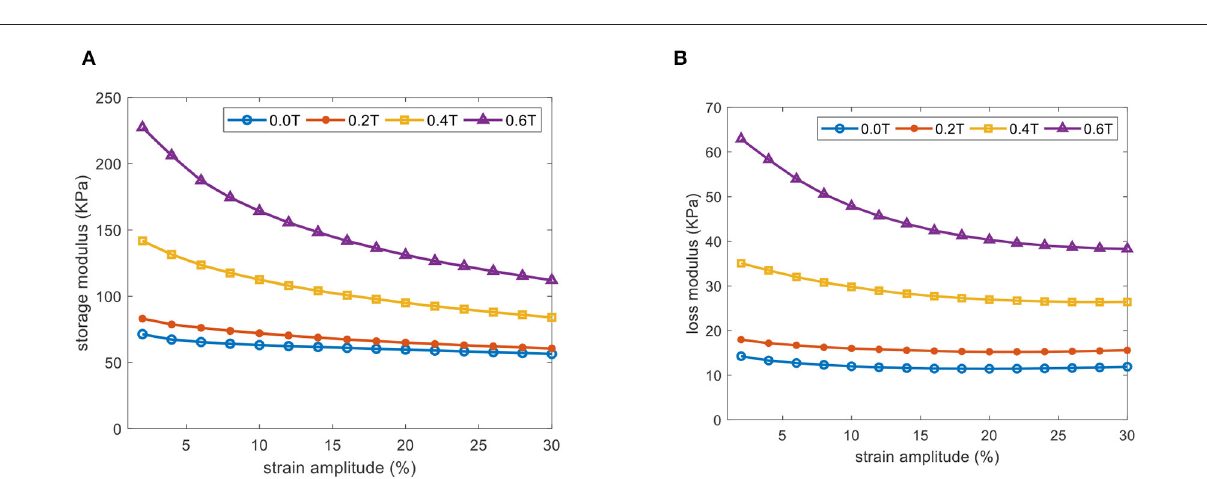
d 4 = 13.27 are identified using the least square method. The results obtained using the models presented in Equations (1) and (2) are compared with those measured experimentally in Figure 5